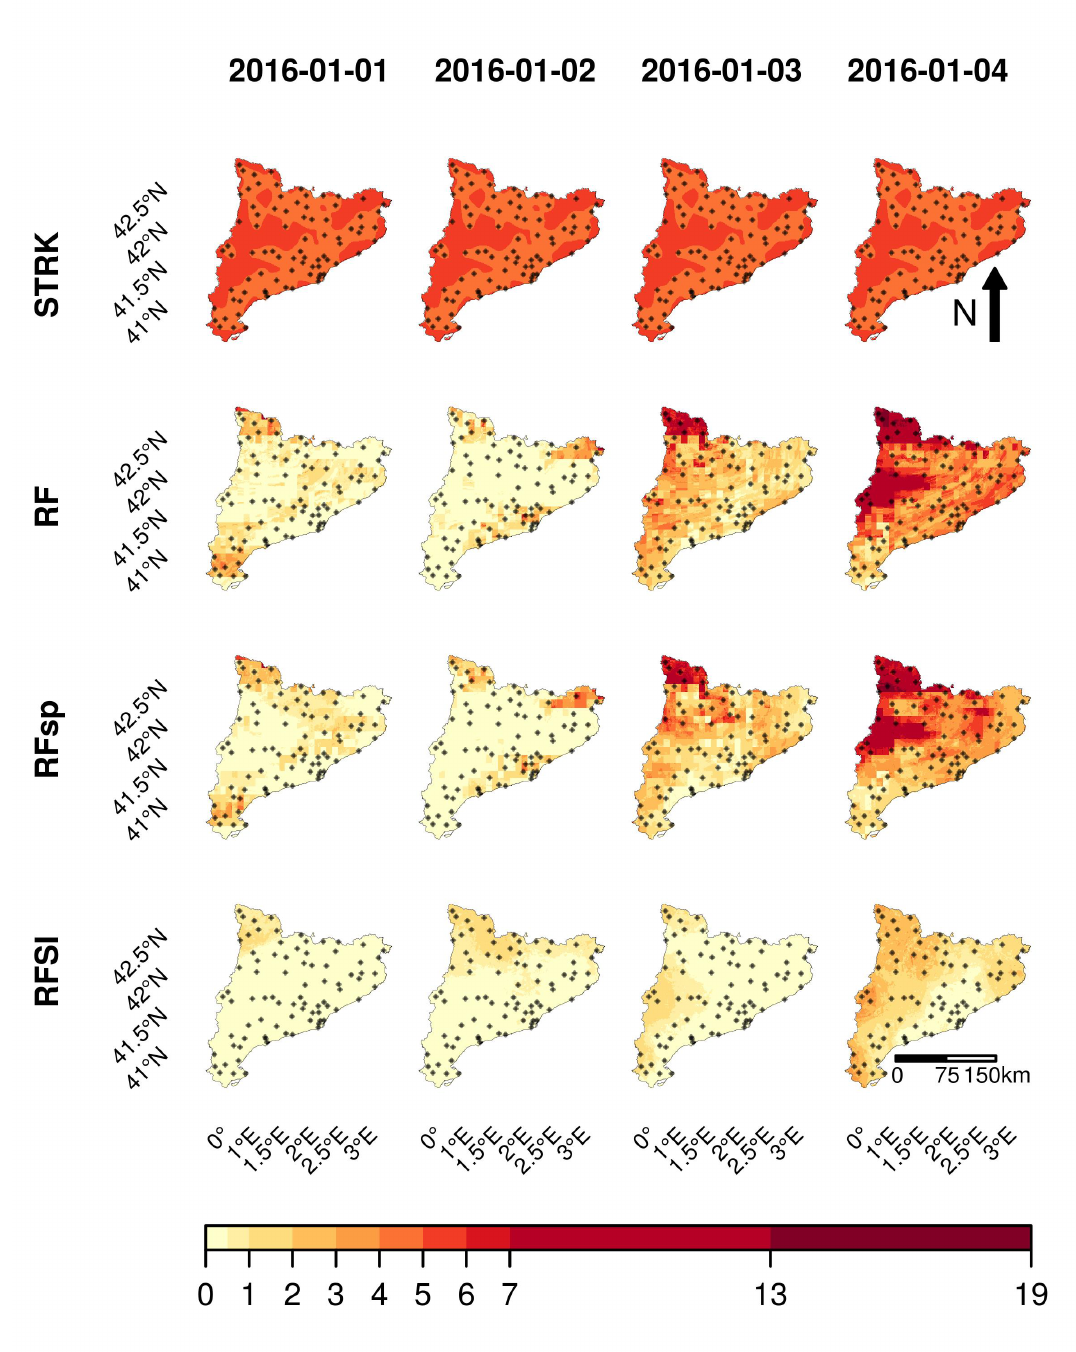
Figure 13. IQR of daily precipitation (mm) for the four models, for 1–4 January